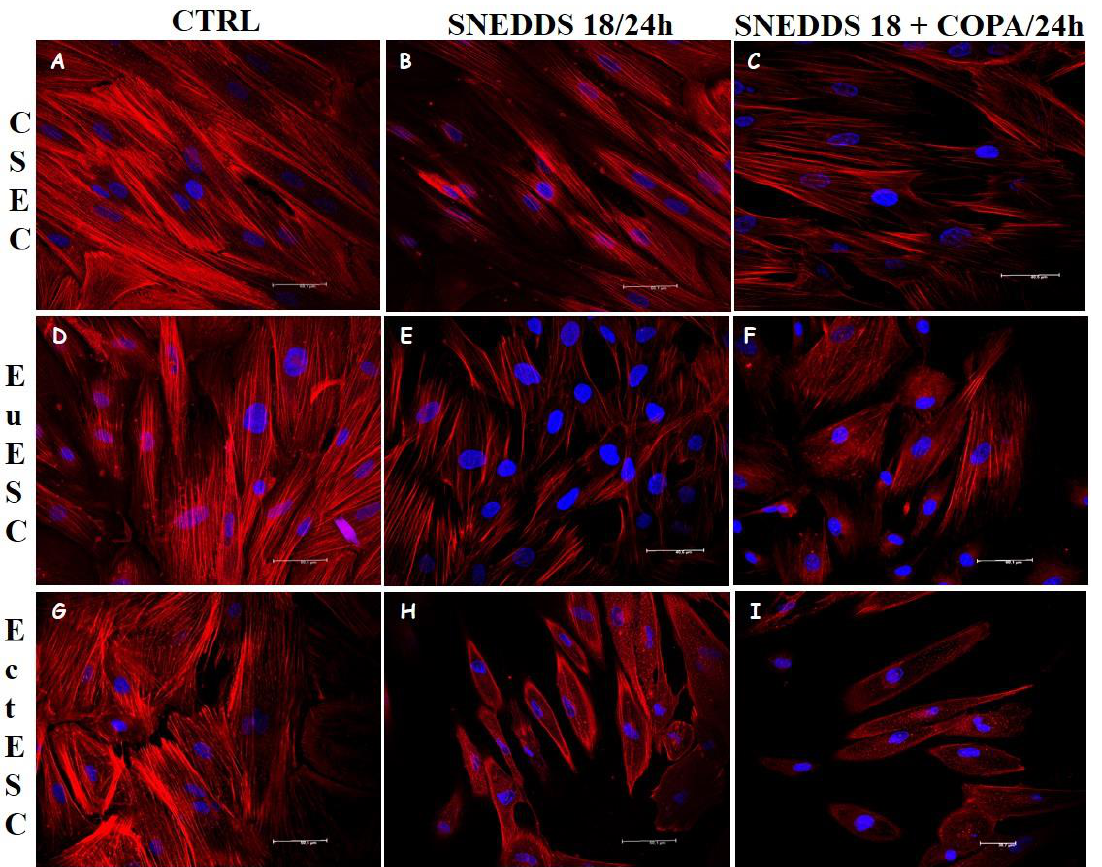
Figure 5. Alterations in actin filaments of ESC cultures after treatment with nanoemulsions. CESC ( A – C ), EuESC ( D – F ), and EctESC ( G – I ) were labeled with Cy3 fluorochrome-coupled fungal phal- loidin toxin (rhodamine, red) or DAPI (nuclear marker, blue) 24 h after treatment with nanoemulsions. Representative images of three independent experiments performed in triplicate. Scale bar = 50 μm. CESC: Endometrial stromal cells obtained from topic endometrium of patients without endometriosis; EuESC: Endometrial stromal cells obtained from topic endometrium of endometriosis patients; EctESC: Endometrial stromal cells obtained from ectopic endometrium of endometriosis patients (endometriotic lesions).